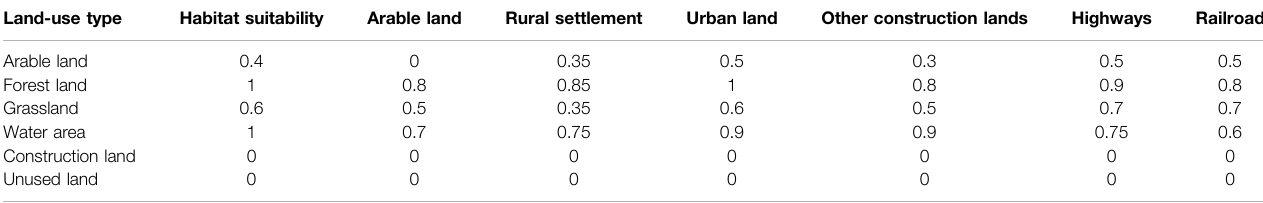
TABLE 3 | Landscape types and their sensitivity to threats.